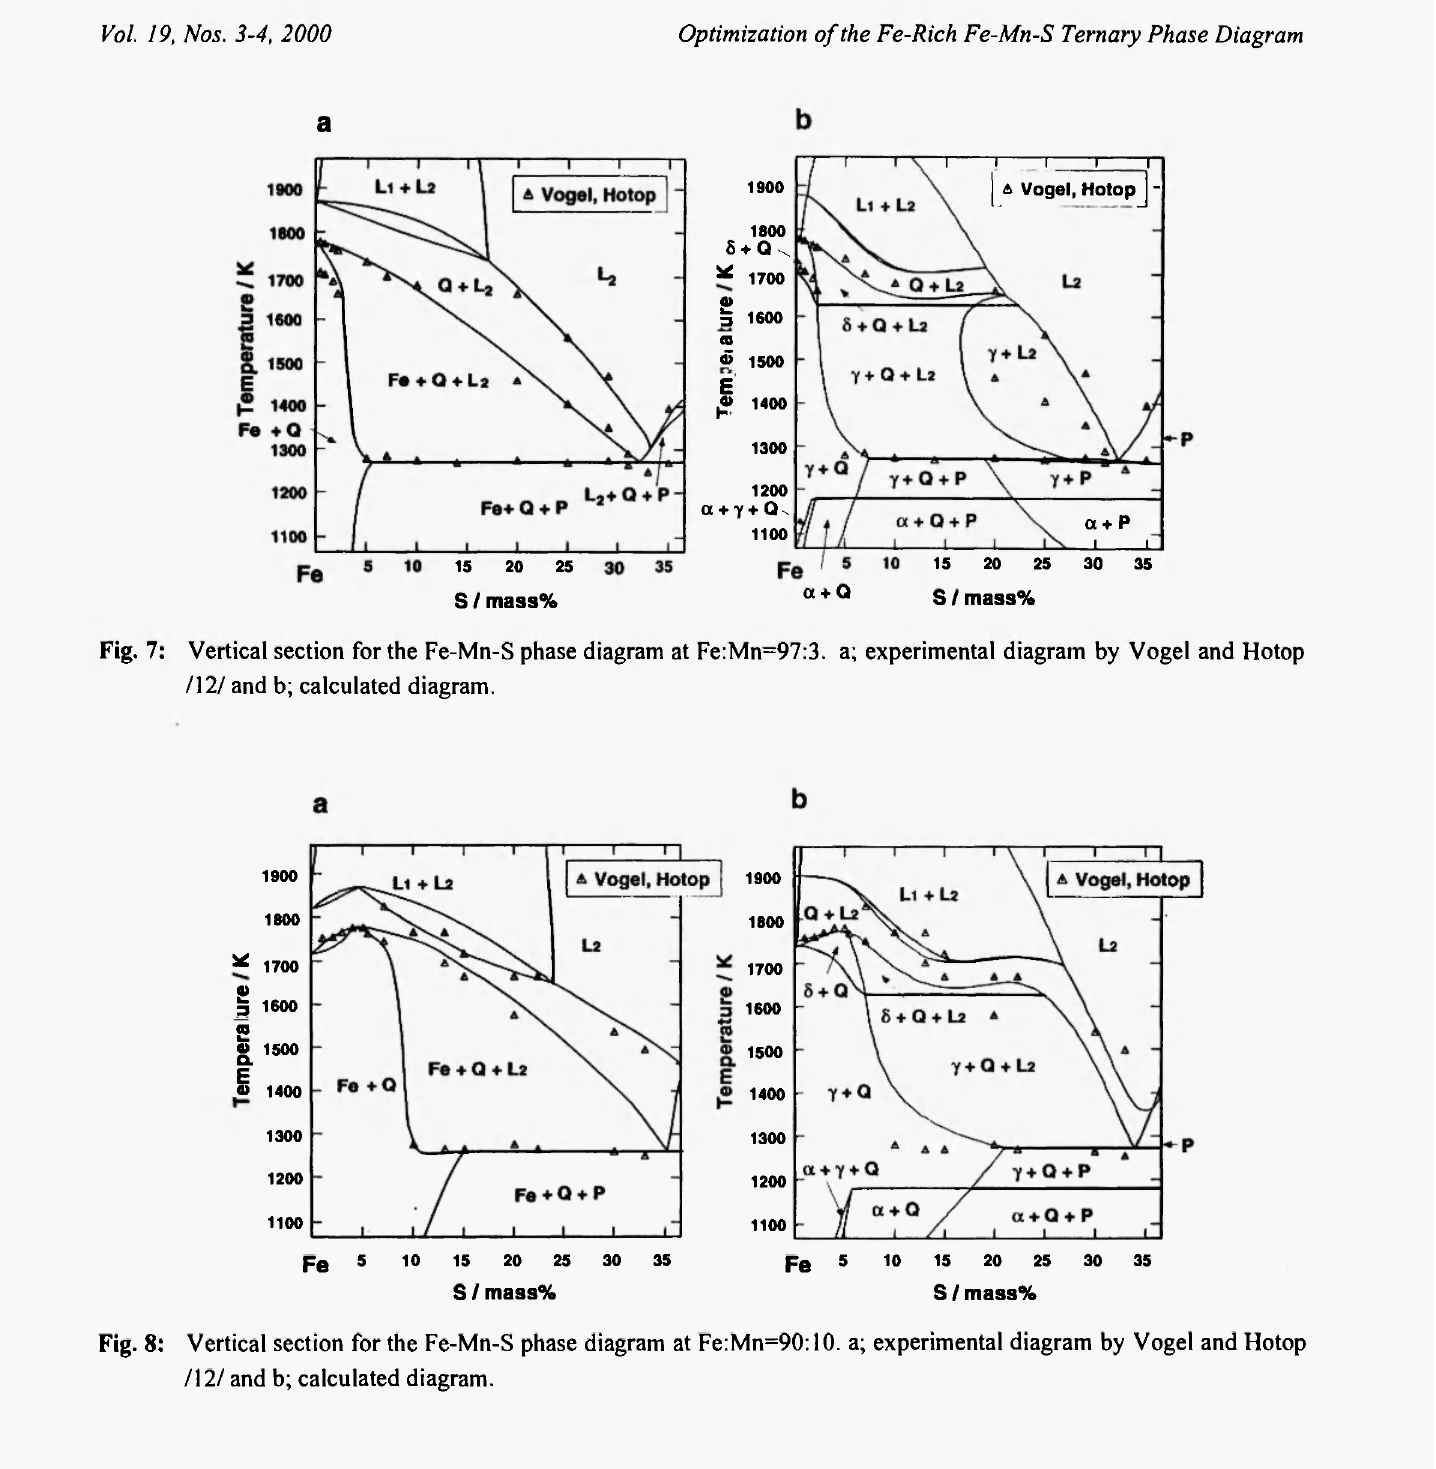
Fig. 8: Vertical section for the Fe-Mn-S phase diagram at Fe:Mn=90:10. a; experimental diagram by Vogel and Hotop /12/ and b; calculated